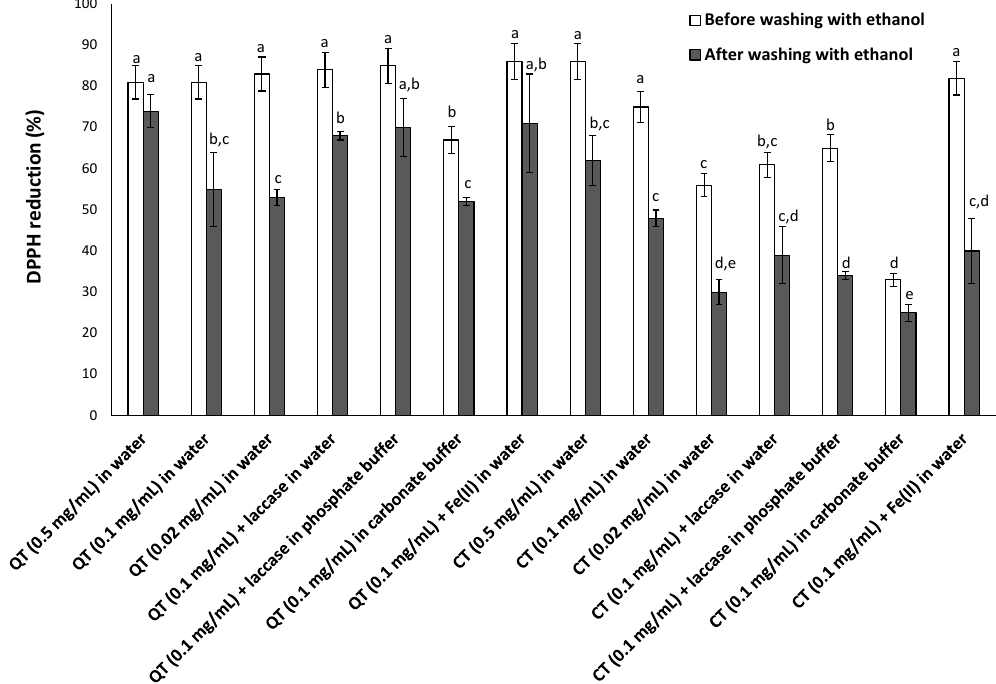
Figure 4. DPPH reduction at 2.5 h by the tannin-coated nylon membrane filters before and after washing with ethanol. Reported are the mean ± SD values from at least three experiments. Values without a common letter are significantly different ( p < 0.05).